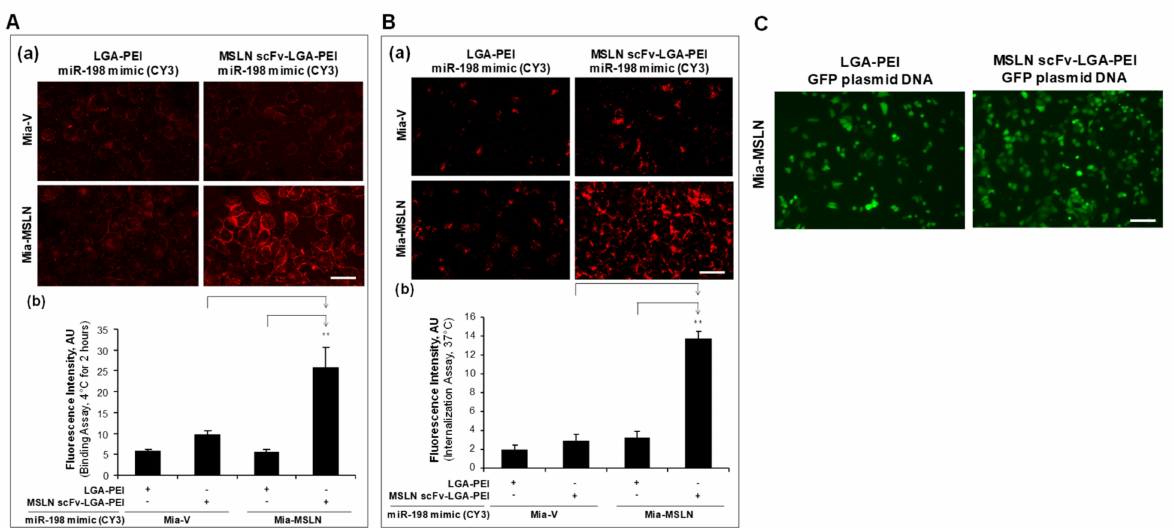
Figure 4. Targeting delivery of MSLN scFv-LGA-PEI nanoparticles (NPs) with/miR-198 mimics to specific cells in vitro. ( A ) Cell binding assay of MSLN scFv-LGA-PEI/miR-198 mimics NPs. miR-198 mimics were labeled with a fluorescence